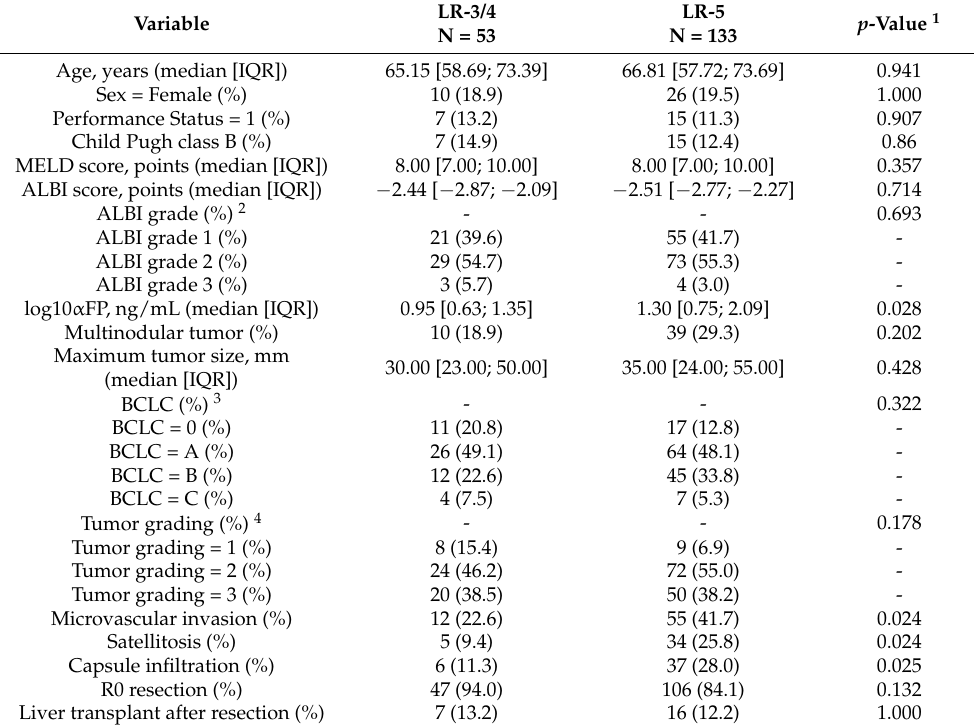
Table 2. Comparison of patients and tumor characteristics by LR-3/4 vs